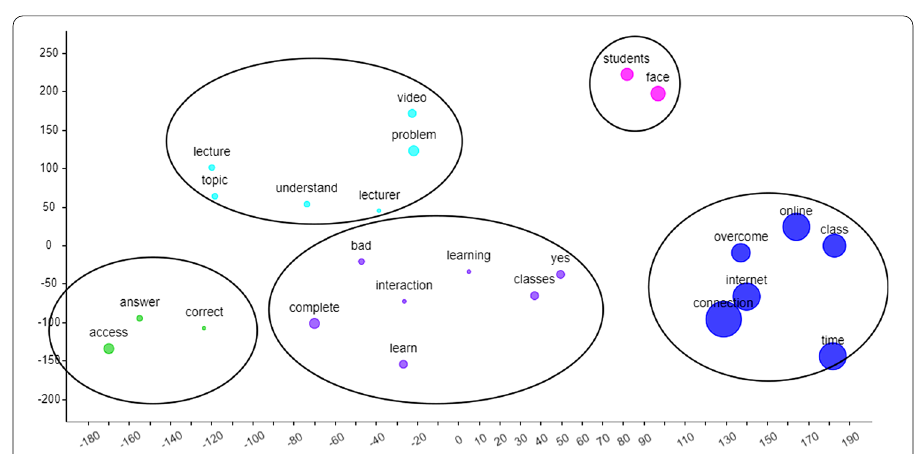
Fig. 7 t-SNE generated clusters for the answers to Question